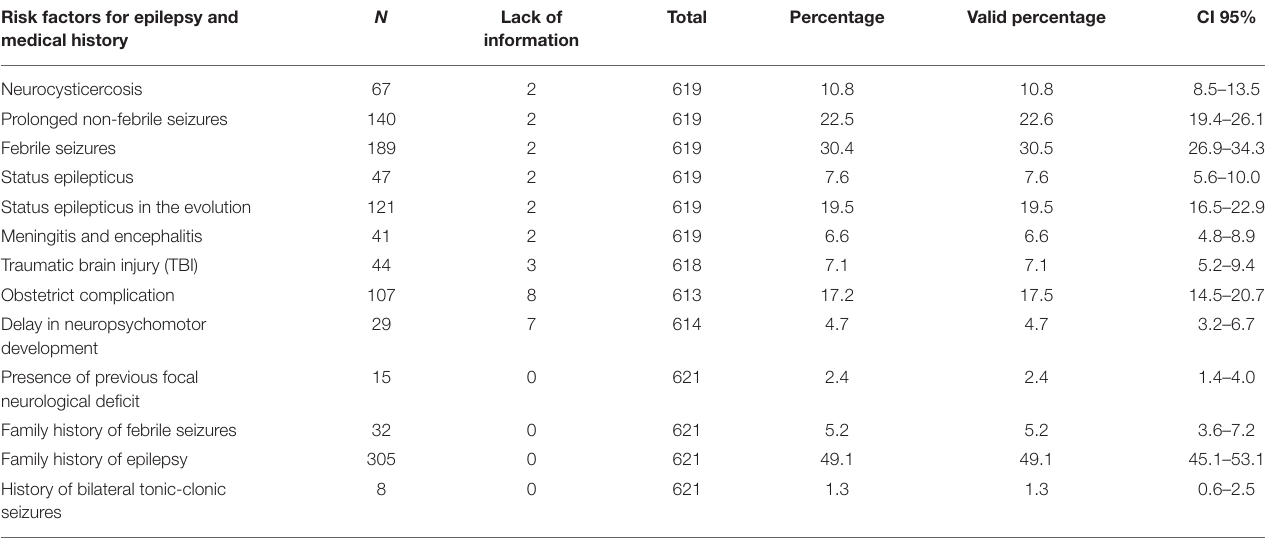
TABLE 1 | Risk factors for epilepsy and medical history. Risk factors for epilepsy and medical history